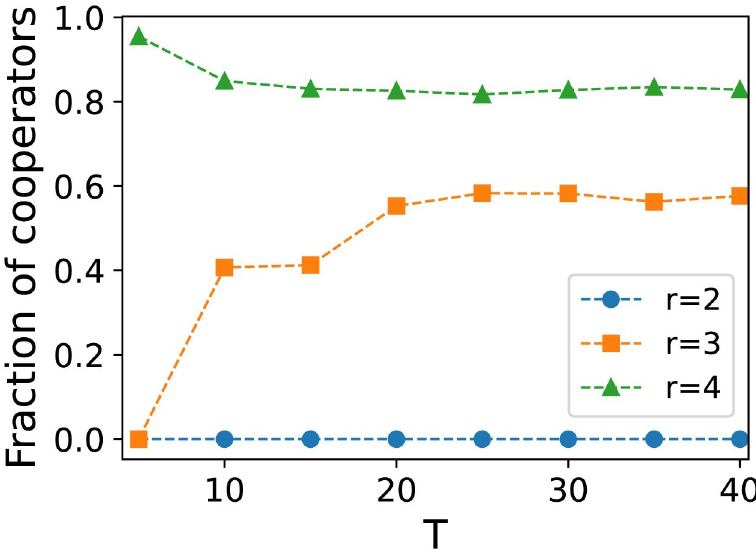
Fig 8. Sensitivity analysis of the trust score threshold T . When the trust score threshold T � 20, the results of cooperation evolution show a relatively stable trend. N = 10000, t = 10000, α = 5, β = 5, and ω = 0.1.